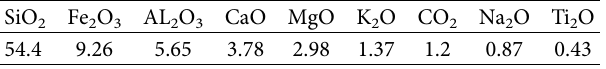
Table 1: Chemical composition of iron ore tailings